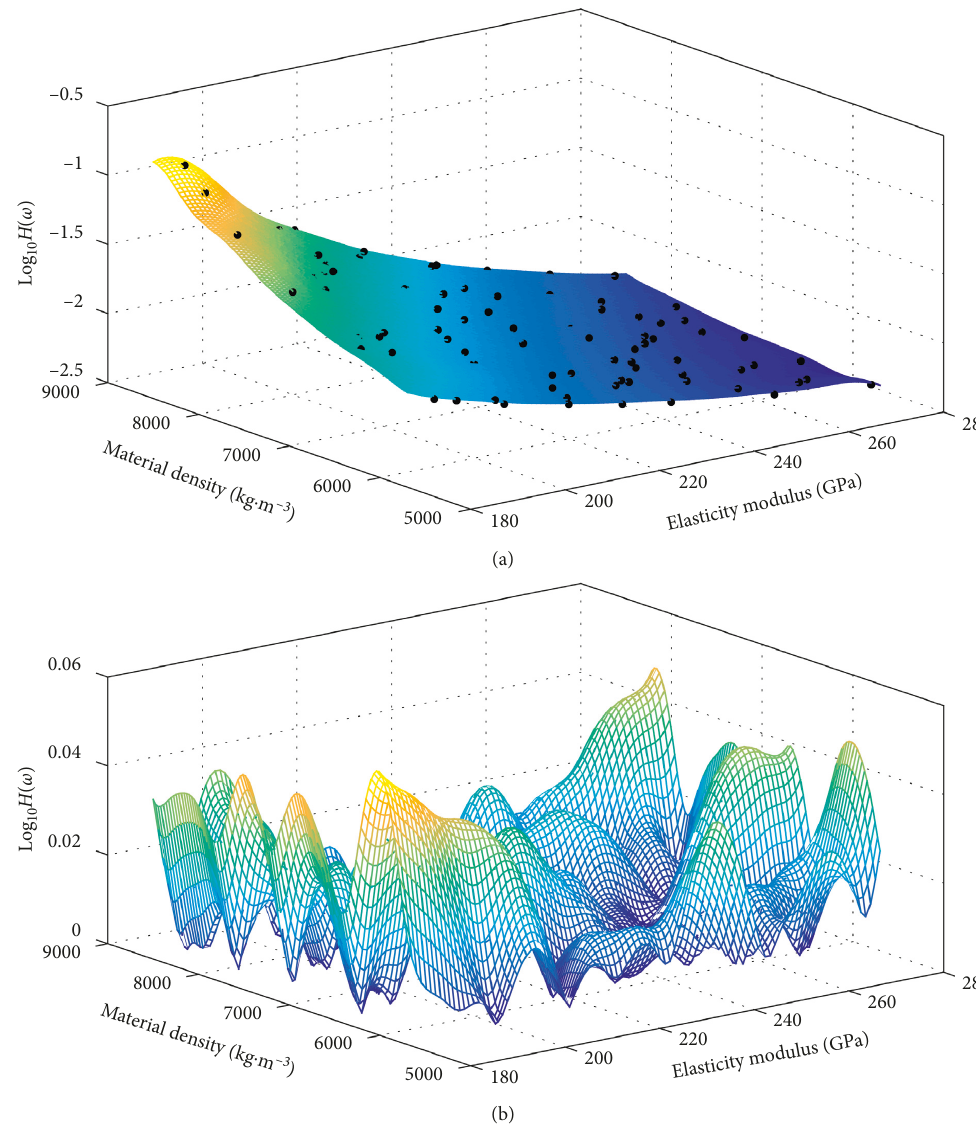
Figure 6: Prediction values of the improved Kriging model. (a) Response values. (b) RMSE values.